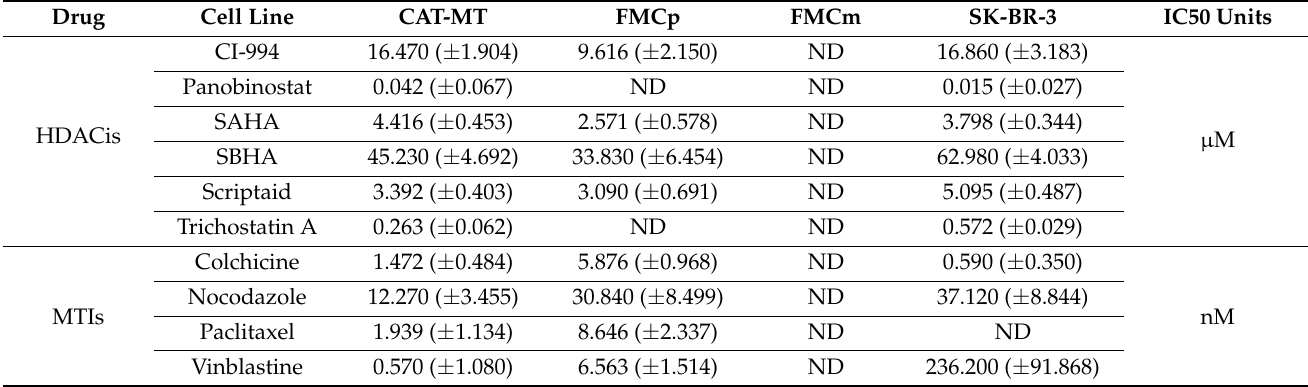
Table 2. Best-fit IC50 values (Mean and SEM) of each HDACi and MTI, calculated using the log (inhibitor) versus response (variable slope) function in Graph Pad Prism